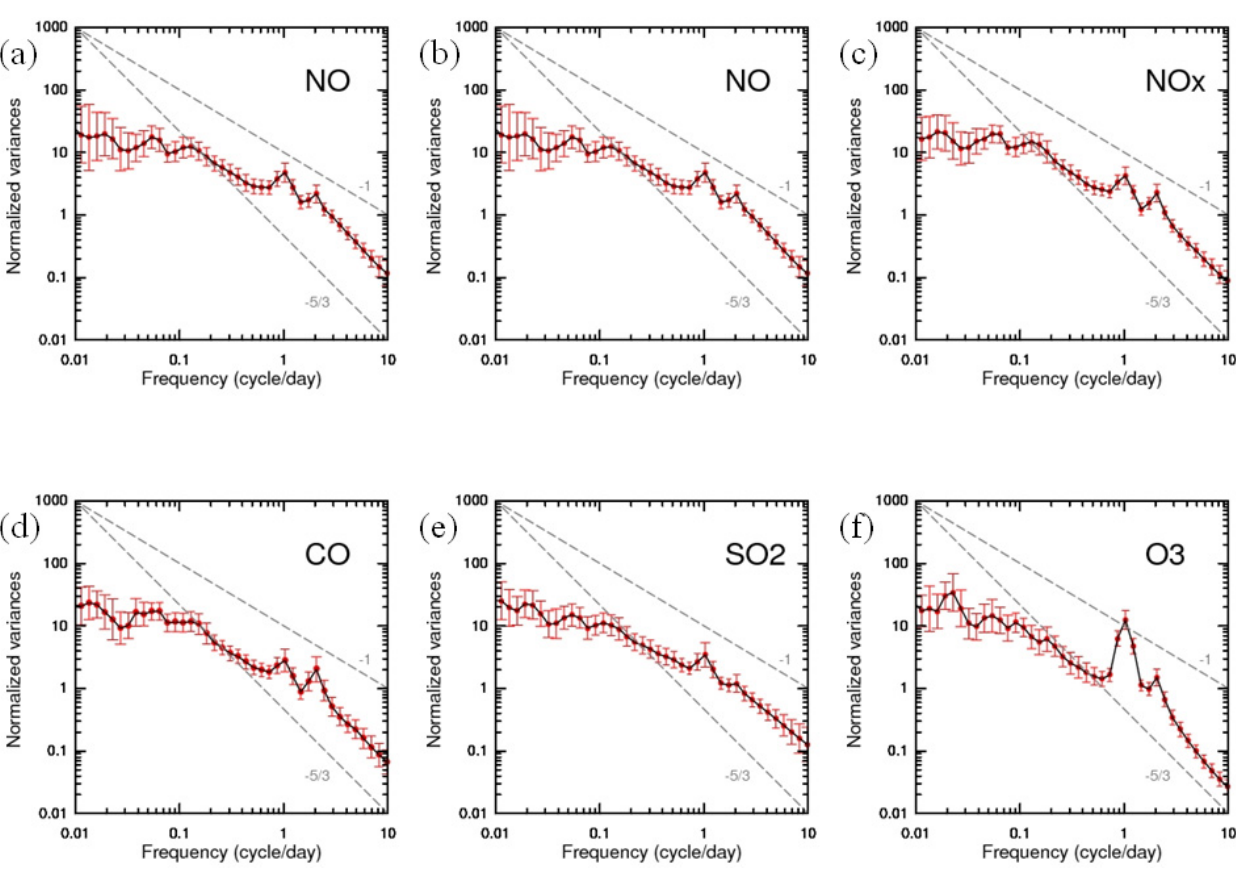
Fig. 3. The CWT spectra (in log-log scale) of the gases, NO (panel a ), NO 2 (panel b ), NO x (panel c ), CO (panel d ), SO 2 (panel e ), and O 3 (panel f ). The black curves are the 74-station averages, and the red bars are standard deviations from the averages. The grey dash lines indicate the power-law scaling of − 5/3 and −